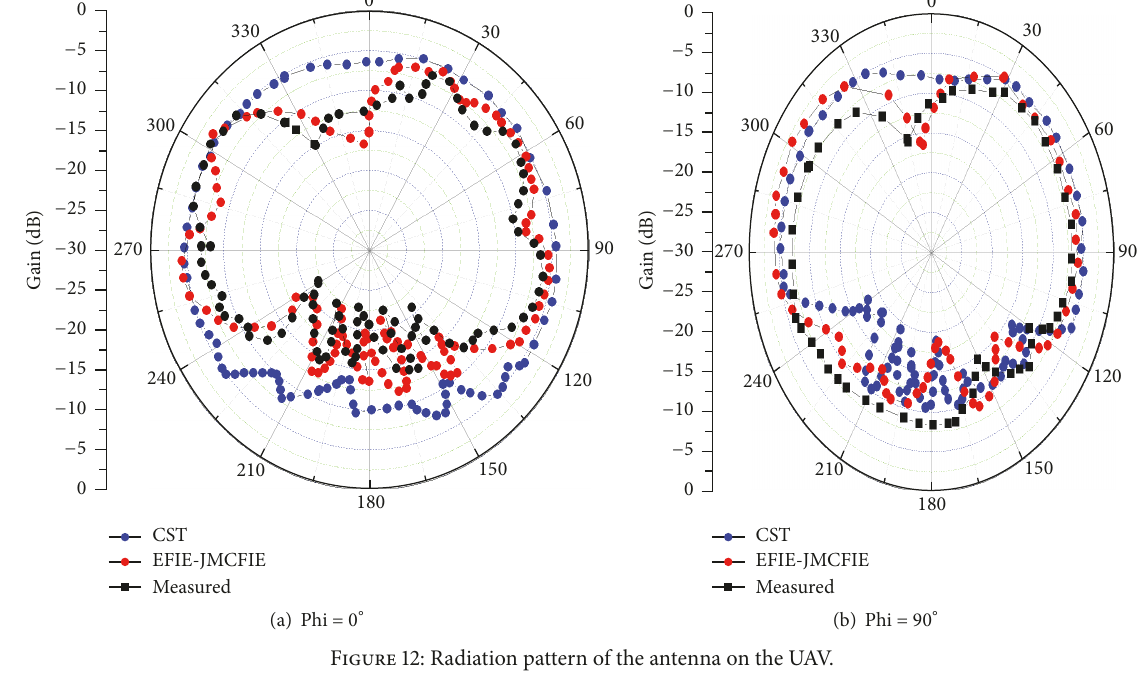
Figure 12: Radiation pattern of the antenna on the UAV.